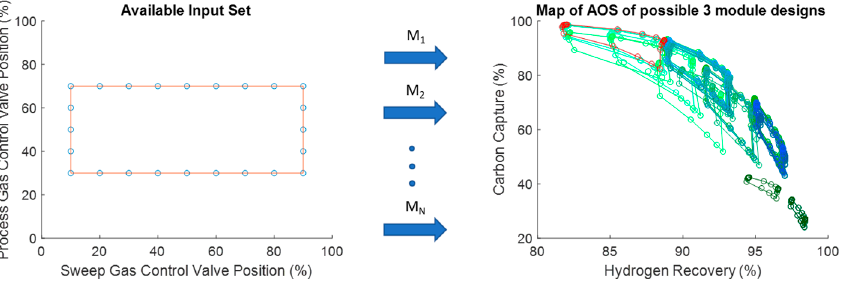
Figure 11. Plot showing all viable 3-mod design AOS’s given the same AIS. Here, the red AOS represents the membrane reactor AOS that was first shown in Figure 8.